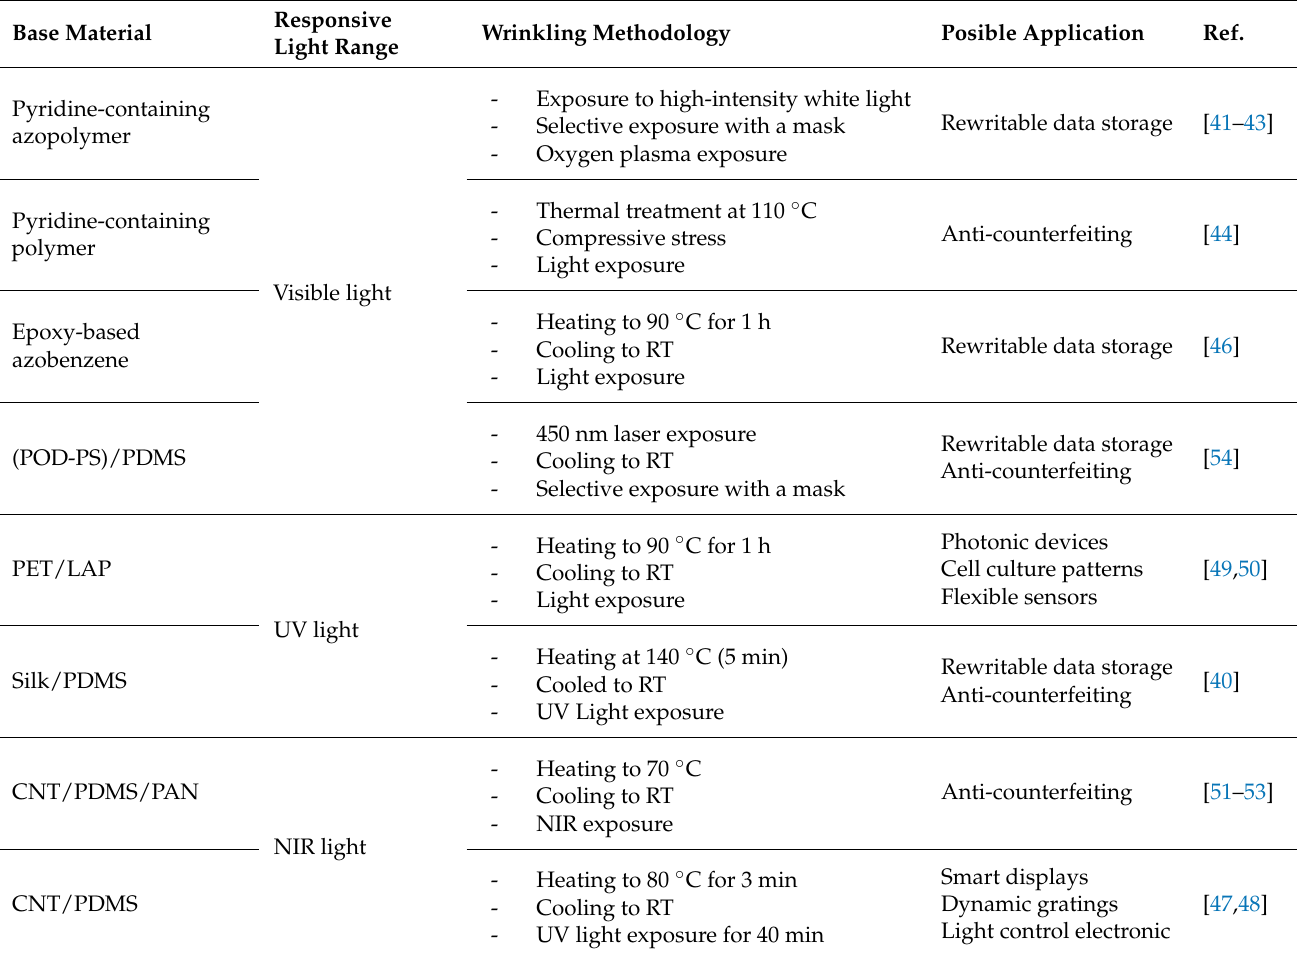
Table 1. Summary of light-responsive materials listed in Section